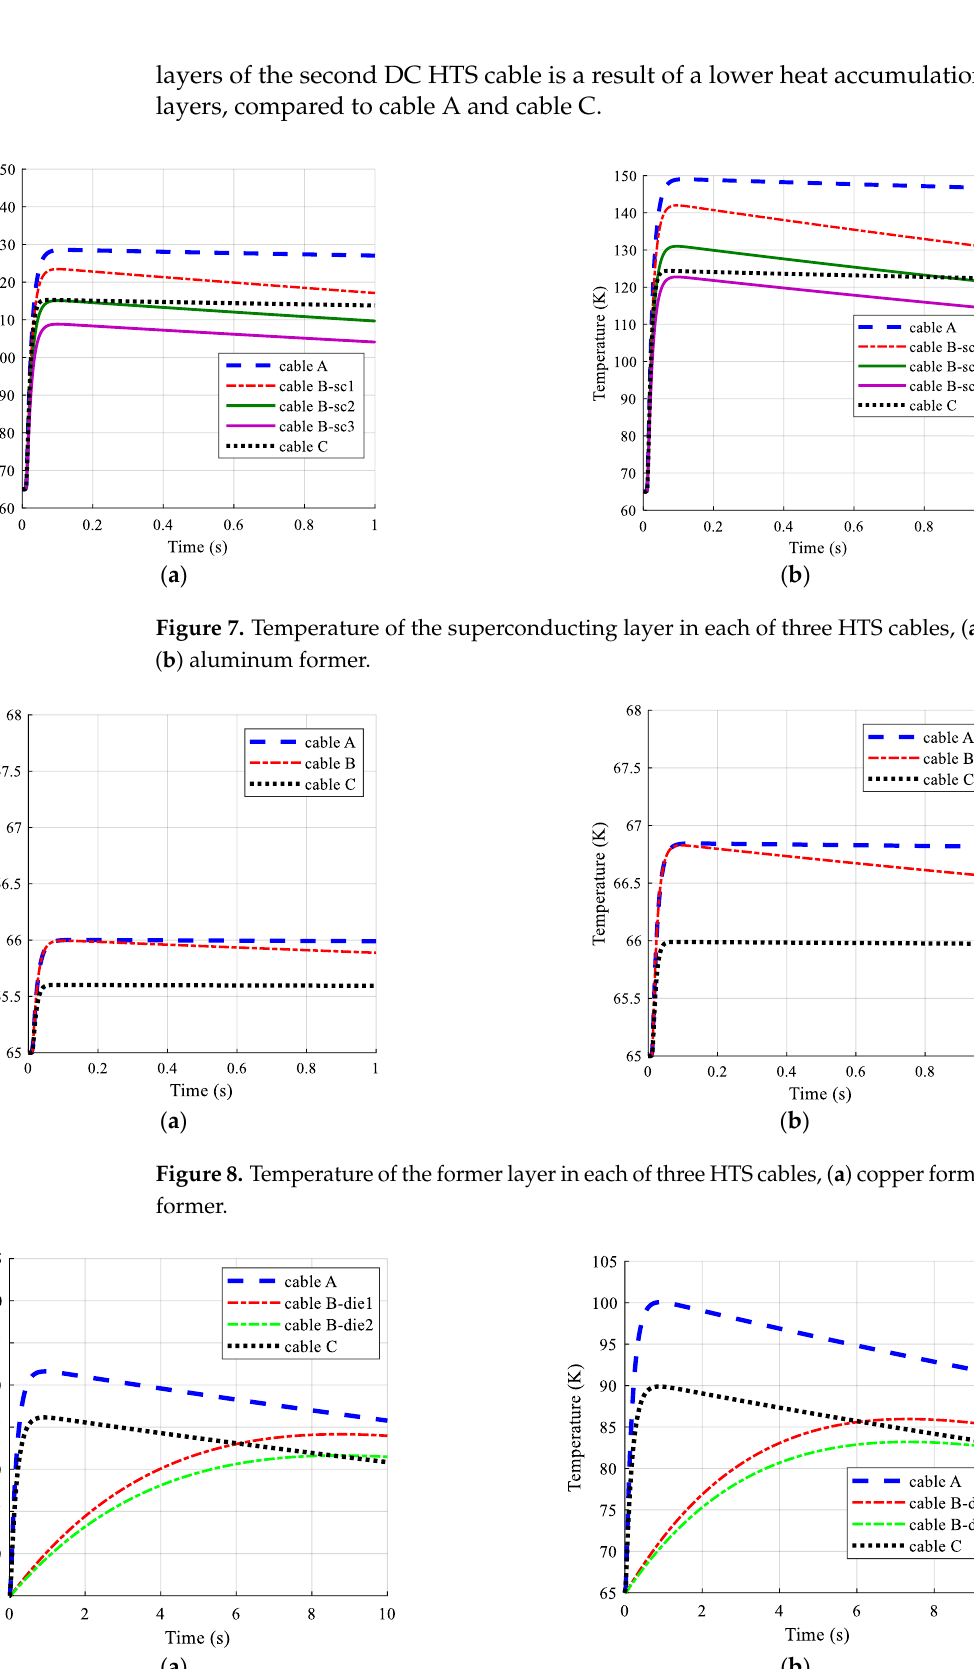
Figure 10. An illustration of fluid weight calculation in a single-layer DC HTS cable. Table 6. Analyzing the specific mass and power density of the optimally designed HTS cables. Cable Type